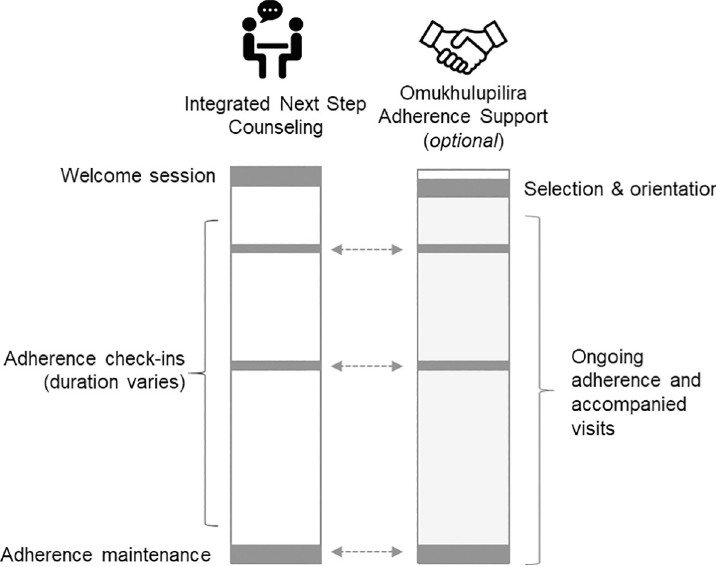
Fig 1. Tonse Pamodzi intervention overview: Enhanced ART & PrEP adherence